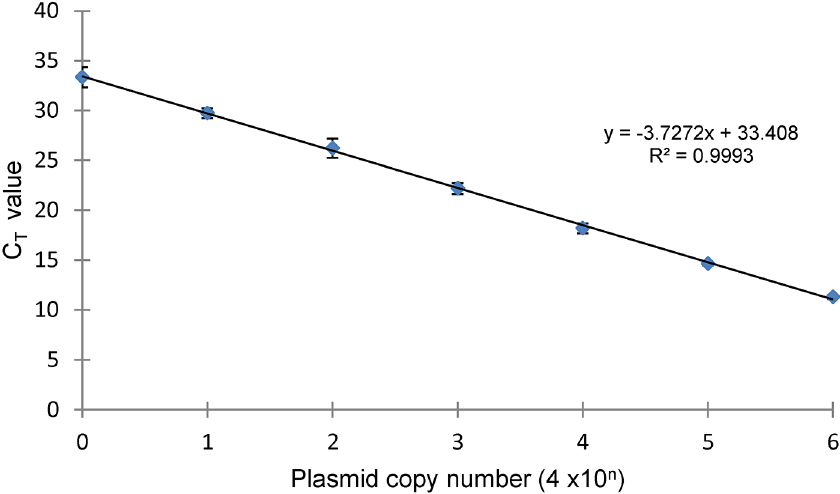
Fig 2. DNA doubling efficiency. Linear amplification of circular plasmid DNA was between copy numbers of 4 x 10 0 and 4 x 10 6 , and generated a standard curve with calculated efficiency of 86% from y-slope (-3.72) with correlation coefficient (R 2 ) of